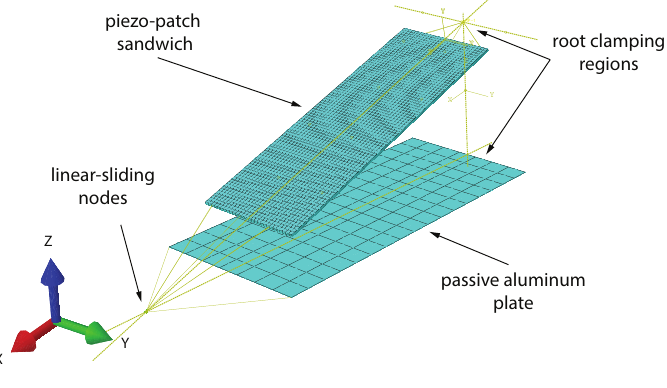
Figure 4. HBMA Abaqus FE